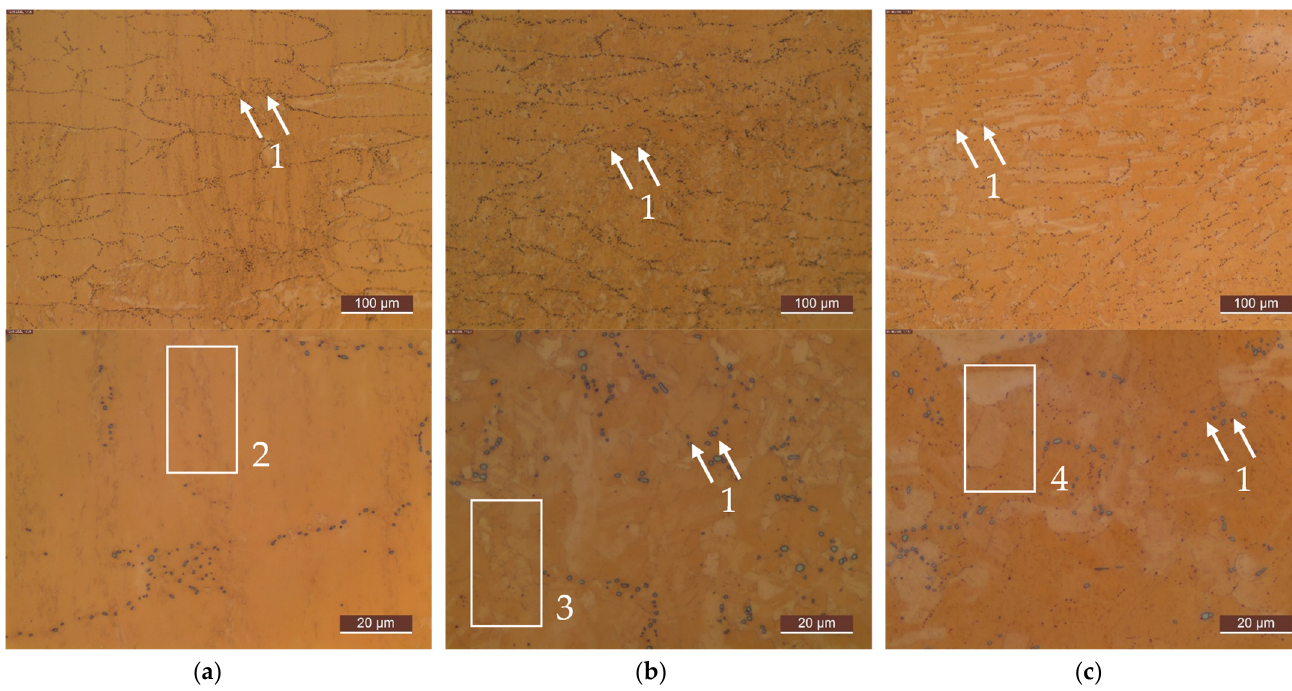
Figure A6. Microstructure evolution of CuCr0.7 during DSC measurements in the optical microscope: specimen with prior cold rolling; ( a ) initial state with 75% cold rolling; and after DSC measurement; ( b ) condition 1; ( c ) condition 2; showing a fine network of undissolved chromium particles (1), an area visualizing the cold working structure (2), an area primary of recrystallization (3), and one of secondary recrystallization (4).